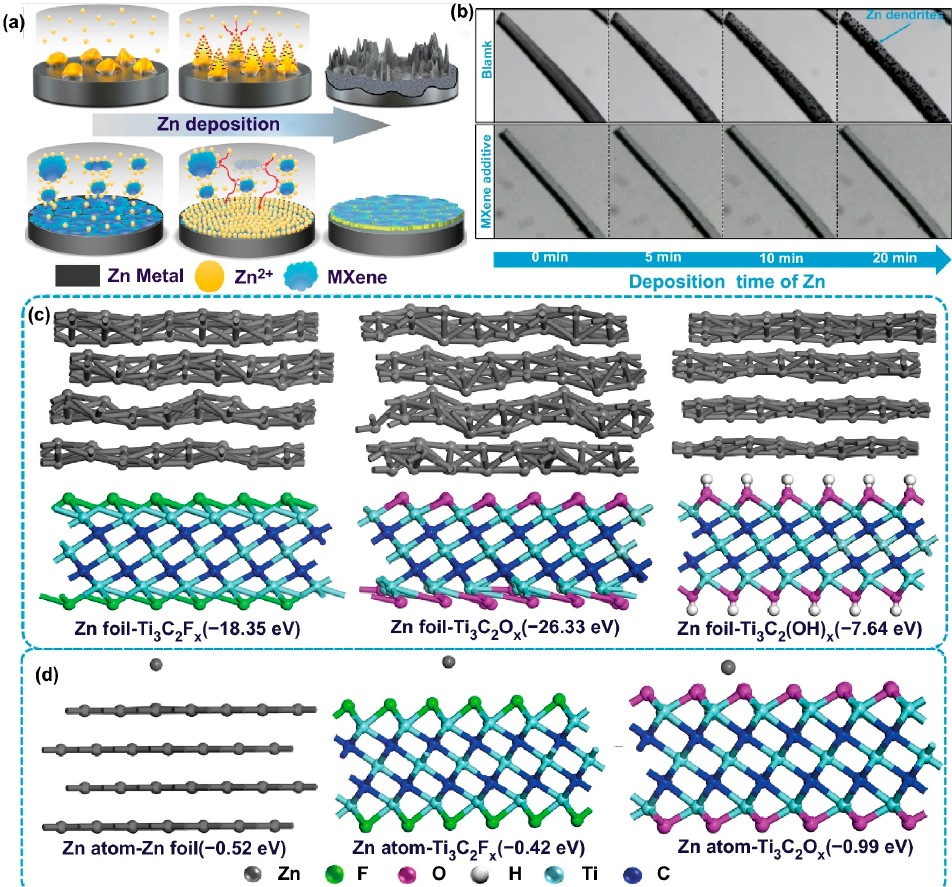
Figure 16. ( a ) Schematic illustration of the effect of MXene additive on the Zn deposition process. ( b ) In situ optical microscopy observation of Zn deposition at 4 mA cm − 2 in blank ZnSO 4 electrolyte and MXene-added electrolyte. Density functional theory calculation models of ( c ) Ti 3 C 2 T x adsorbed on Zn foil and ( d ) Zn atoms absorbed on Zn foil, Ti 3 C 2 T x and the corresponding binding energies. Reproduced with permissions from Ref. [109]. Copyright © 2021 Springer-Verlag London Ltd.